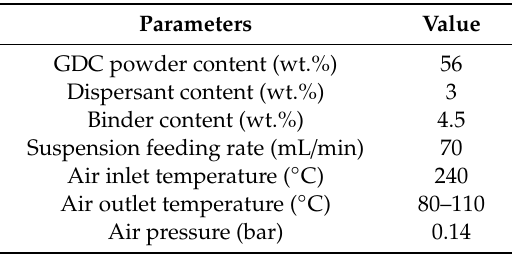
Table 1. Spray drying parameters. GDC: gadolinia-doped ceria.